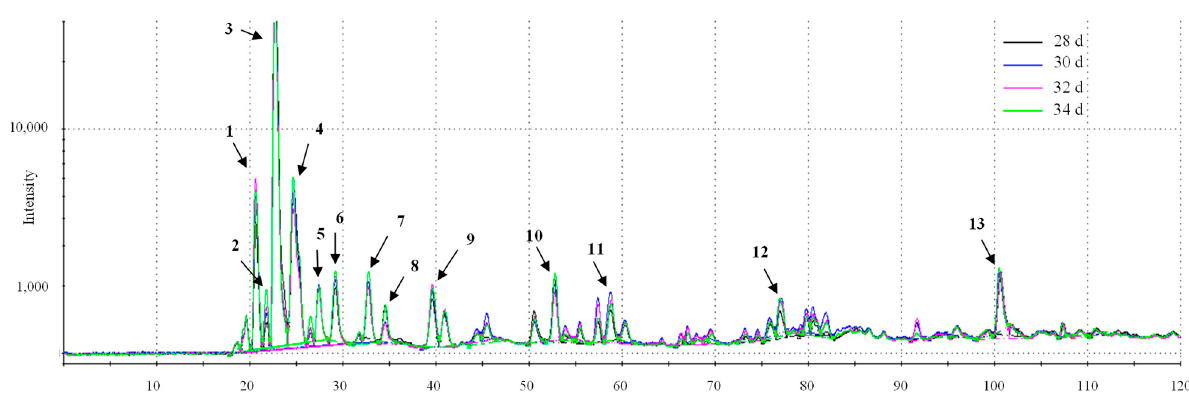
Figure 3. Volatile compounds of cooked cured chicken breast with various marketing ages; 28 d: cured chicken breast with 28 days of marketing age; 30 d: cured chicken breast with 30 days of marketing age; 32 d: cured chicken breast with 32 days of marketing age; 34 d: cured chicken breast with 34 days of marketing age. Peaks are reported in order of elution: 1, acetaldehyde; 2, trimethylamine; 3, methyl formate; 4, 2-propanol; 5, 2-methylpropanal; 6, 2-propanol; 7, ethyl acetate; 8, butan-2-one; 9, 3-methylbutanal; 10, pyrrole; 11, hexanal; 12, octanal; 13, methyl eugenol.